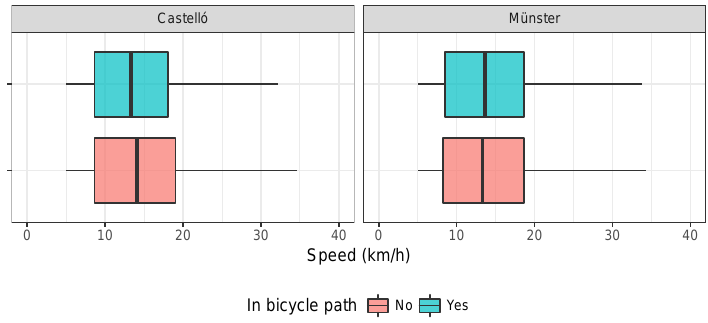
Figure 11. Average cycling speed and bicycle